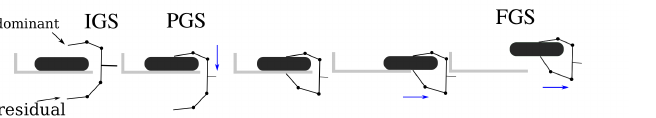
Figure 11. The concept of the grasp strategy for grasping the “pill box” from a high